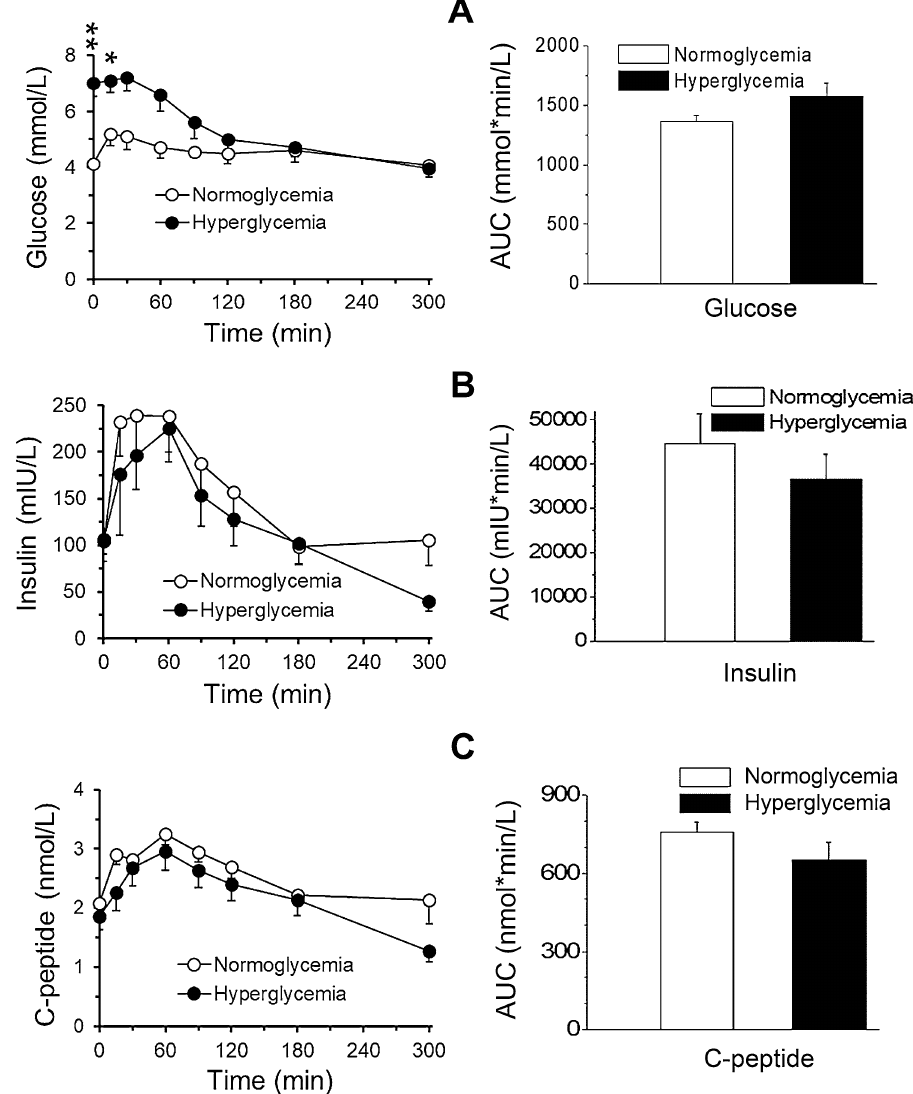
Figure 6. Time course for changes in plasma glucose, insulin, C-peptide, TG and acetaminophen concentrations following nasogastric meal administration at the time of 0 min (the baseline) in normoglycemic (n = 5) and hyperglycemic (n = 11) obese monkeys. ( A – E ) are the concentration changes (left panels) following the time after meal administration and their corresponding AUCs (right panels) of plasma glucose, insulin, C-peptide, TG and acetaminophen, respectively. These AUCs did not show significant differences ( p > 0.05) between normoglycemic and hyperglycemic